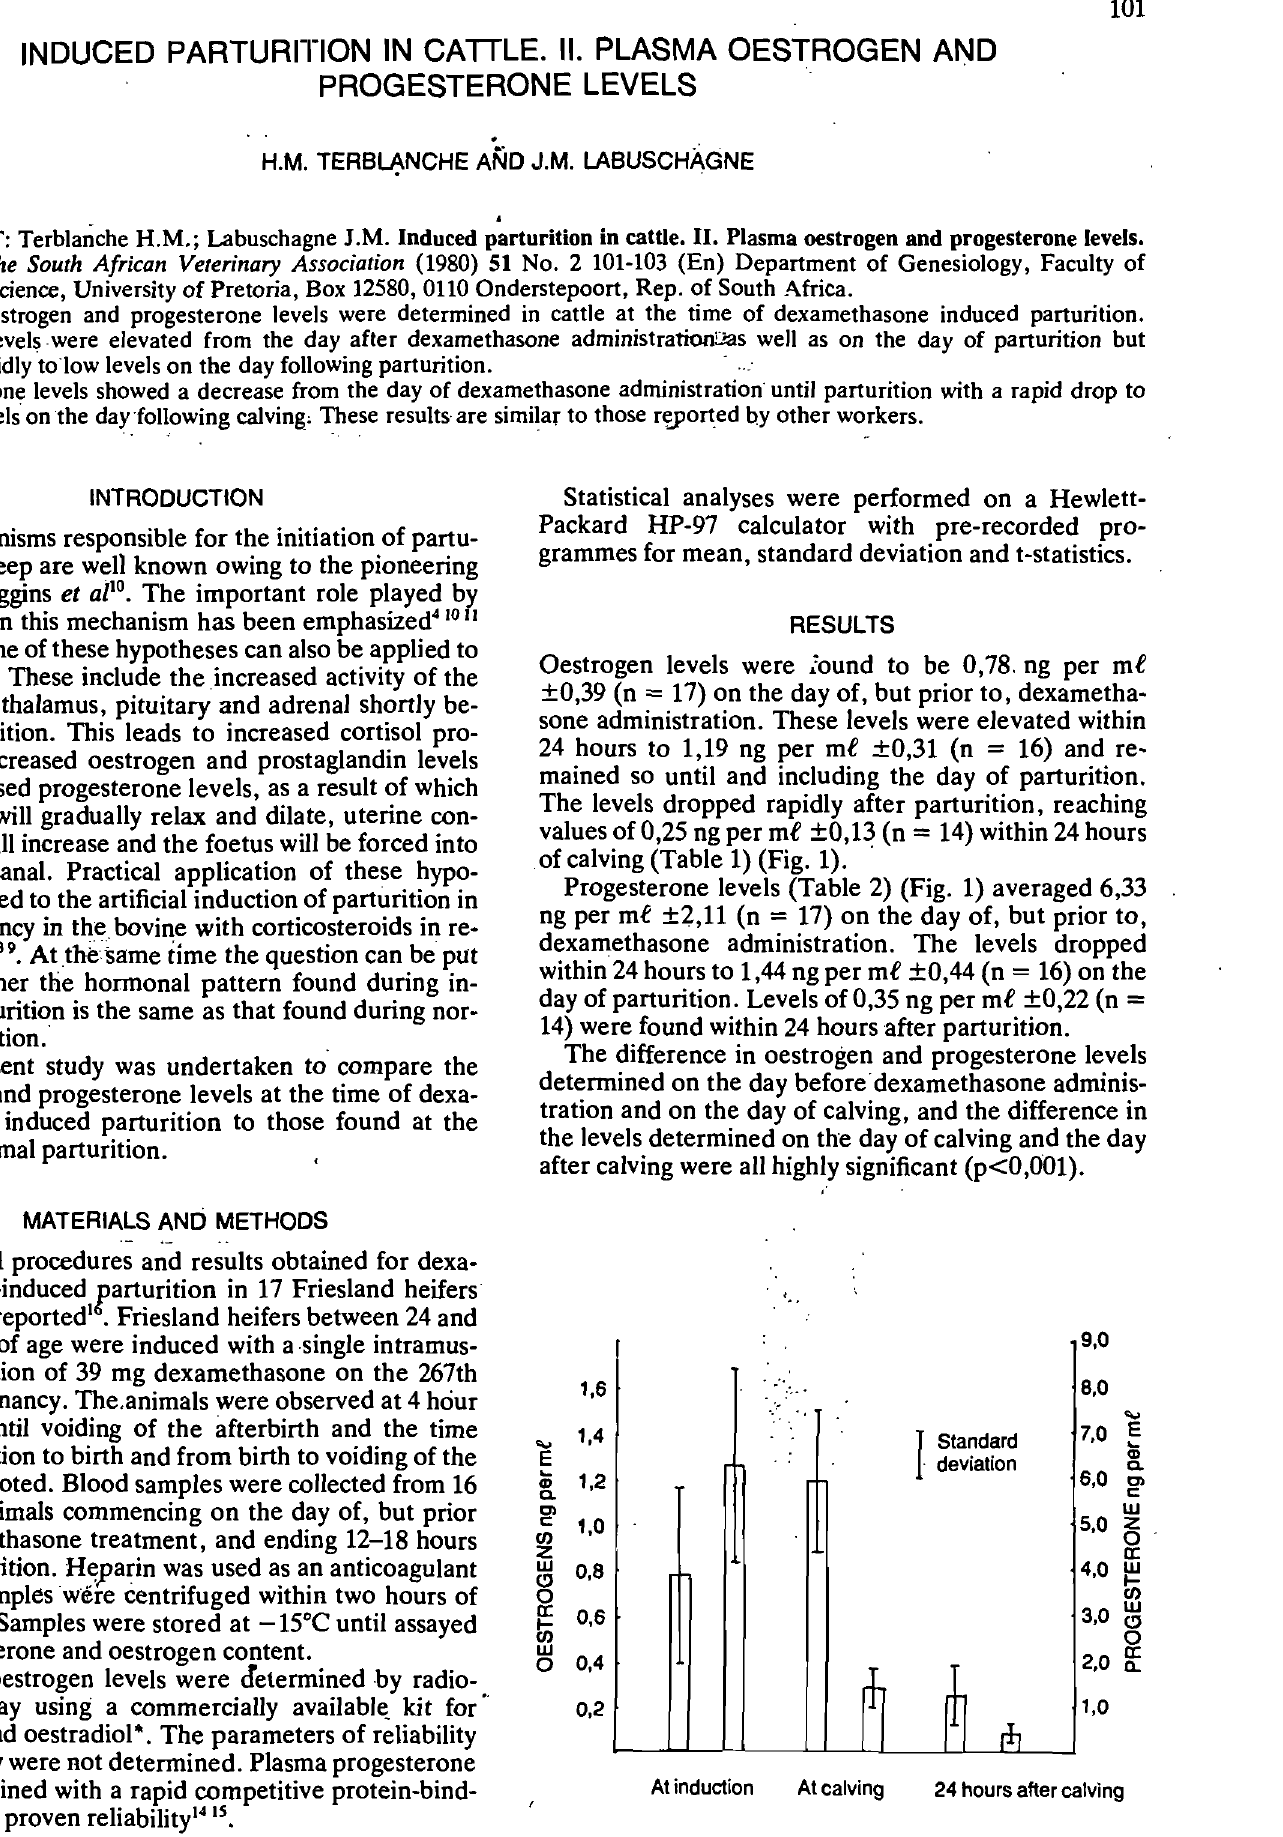
Fig. 1. Mean oestrogen and progesterone levels (ng per me) at induction, at calving and 24'hours after calving.